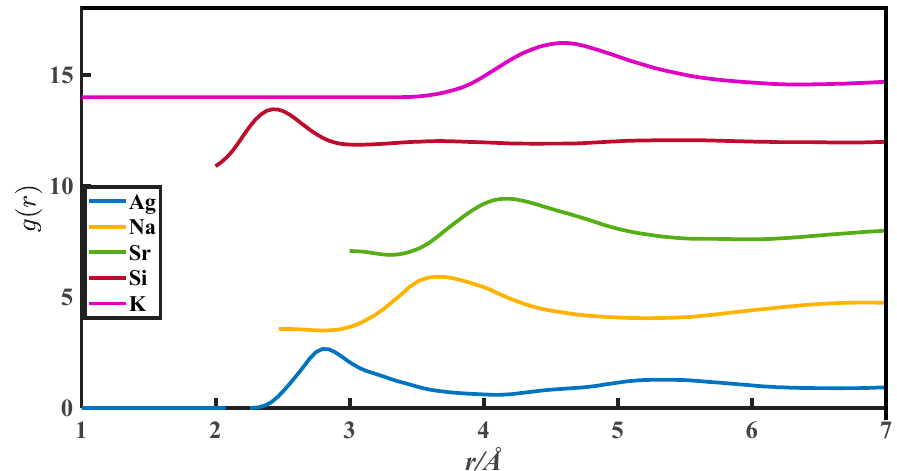
Figure 3. The pair distribution function of Ag, Na, Sr, Si, and K.